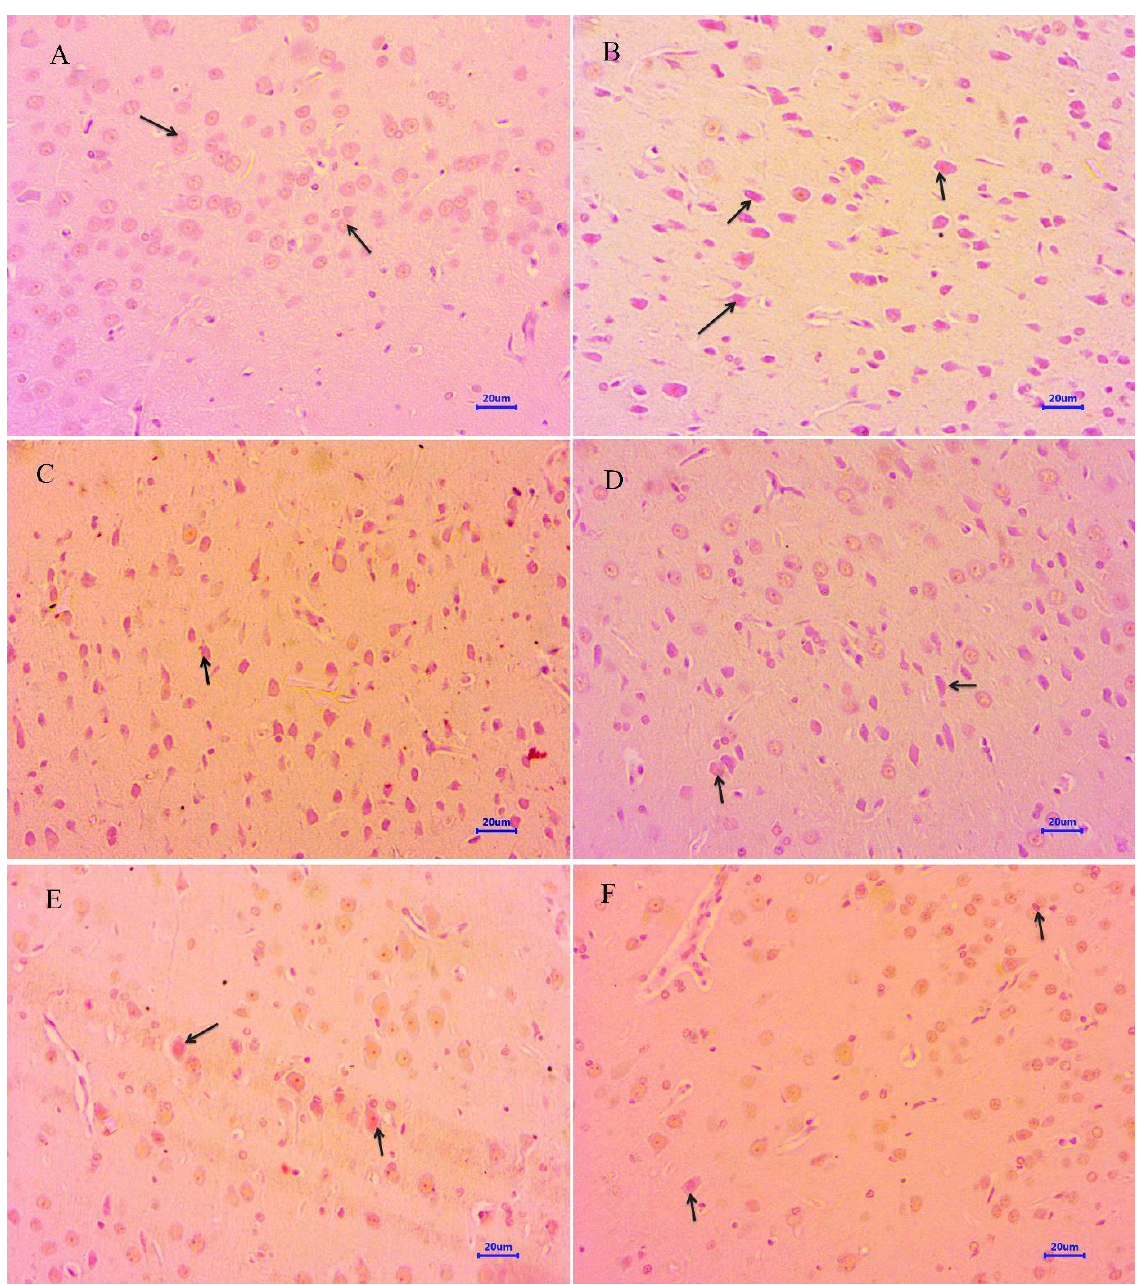
Figure 9. Effect of quercetin and quercetin administered with memantine on Congo red-stained cortex tissue (400×). ( A ): Normal control, ( B ): Disease control, ( C ): Memantine (20 mg/kg), ( D ): Quercetin (50 mg/kg), ( E ): Memantine + quercetin (20 + 25 mg/kg), ( F ): Memantine + quercetin (20 + 50 mg/kg).